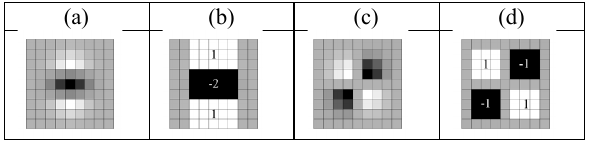
Figure 8. Example of Laplacian of Gaussian (LoG) box filter (Bay et al., 2006).